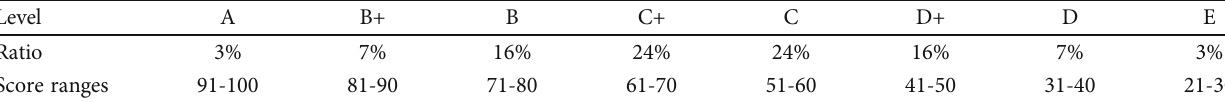
Table 1: Shandong grade scheme division conversion corresponding table.